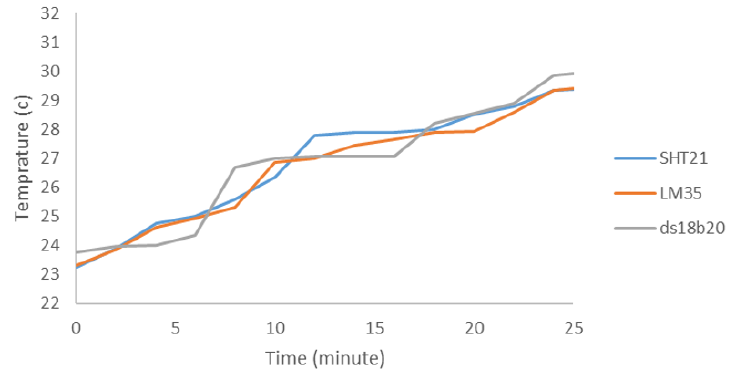
Figure 5. Temperature data collected from the SHT21, Lm35, and Ds18b20 sensors.